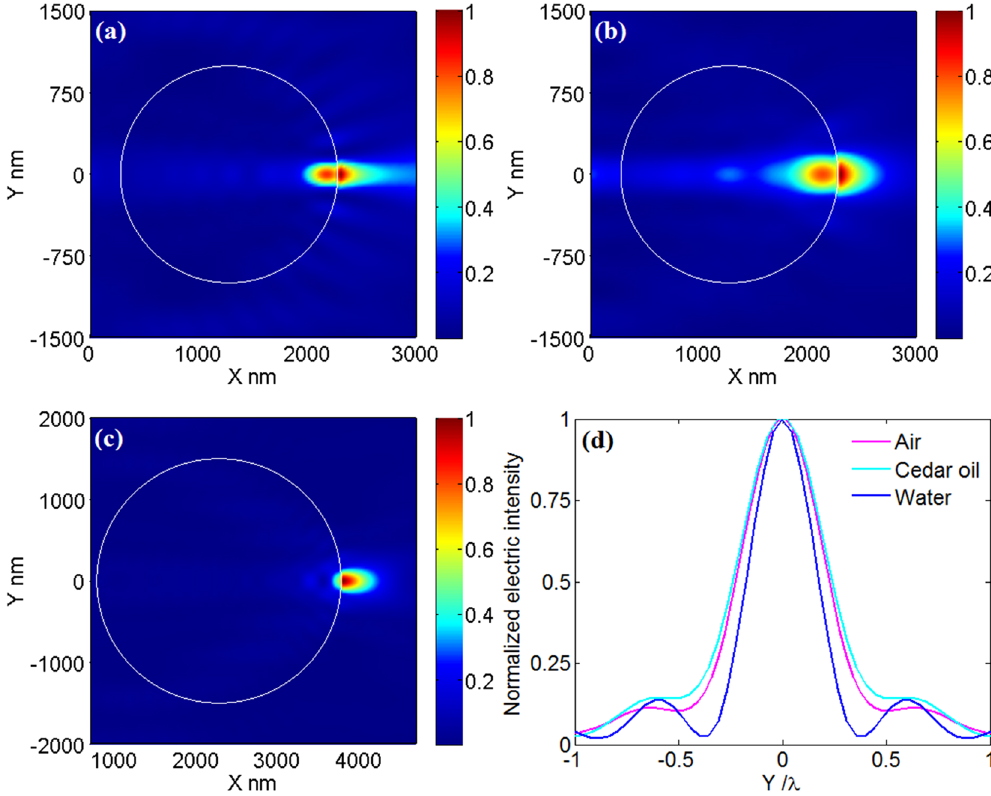
Figure 3. Electric intensity distribution around the microsphere immerged in ( a ) deionized water, ( b ) air, ( c ) cedar wood oil. The radii in ( a – c ) are 1 μ m, 1 μ m and 1.5 μ m, respectively, and the electric intensity is normalized respectively to unity. ( d ) The transverse curves at the maximum value of electric intensity for ( a – c ). The horizontal axis is normalized respectively to the wavelength in surrounding medium, the same for the following.